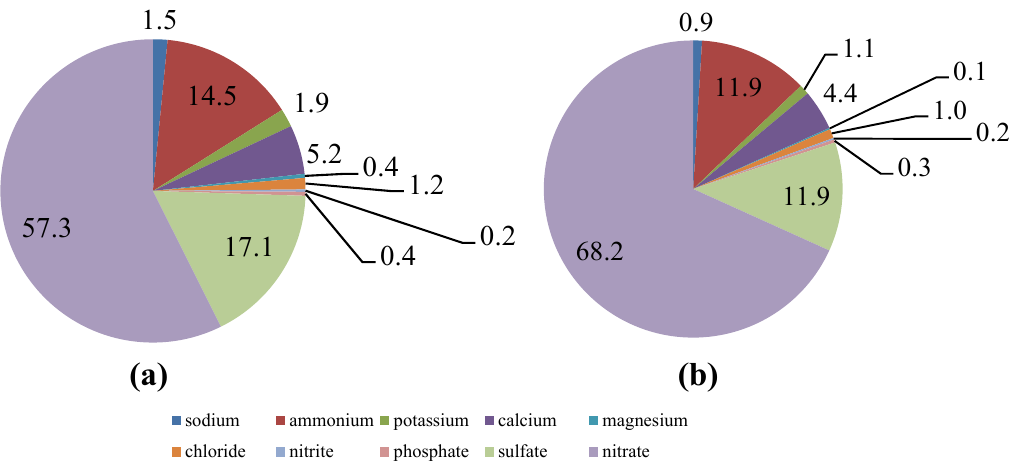
Figure 3. Relative contributions of ionic species to PM 2.5 in CEN ( a ) and MIR ( b ).